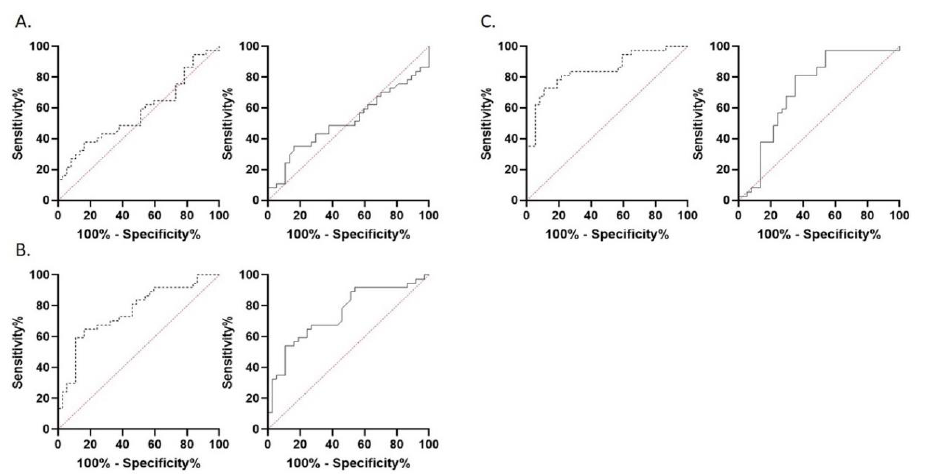
Figure 3. Receiver-operating-characteristics (ROC) analysis of ADC measurements for differentiation of GBM and PCNSL. ROC analysis of apparent diffusion coefficient of selective (dotted line) and unselective (solid line) ROI measurement for differentiation of patients with GBM and PCNSL by minimum ADC ( A ), mean ADC ( B ) and maximum ADC ( C ) values.